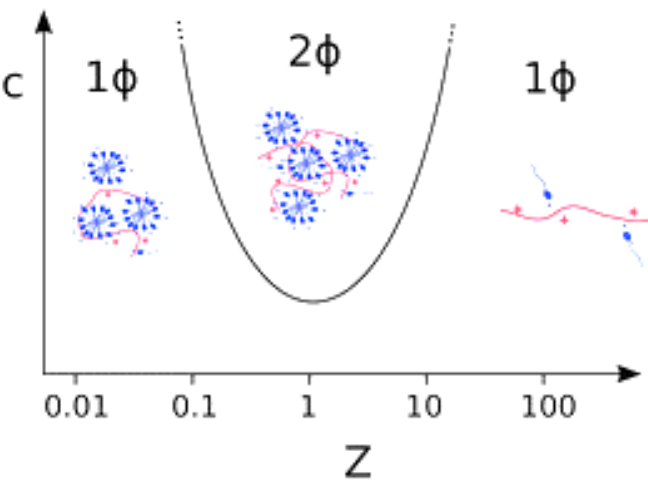
Figure 6. Scheme of the phase diagram for an arbitrary polyelectrolyte–surfactant mixture where the different phases are shown as function of the Z ratio. Reprinted from [94] , Copyright (2013), with permission from the Royal Chemical Society.